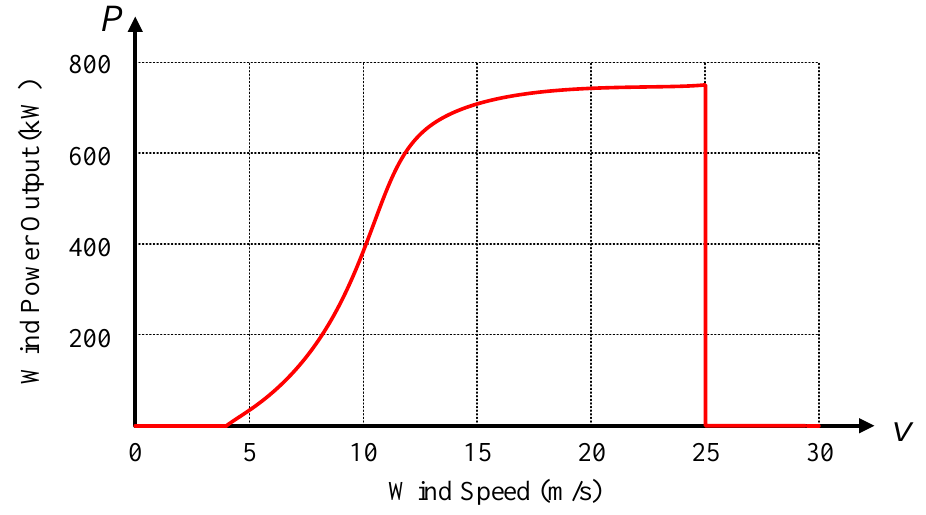
Figure 1. T he manufacturer’s power curve (MPC) . Figure 1. The manufacturer’s power curve